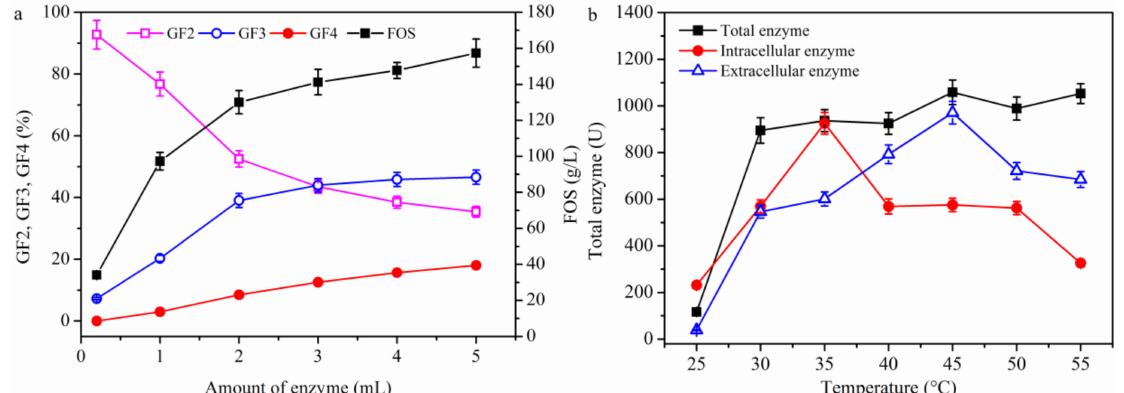
Figure 8. Effect of ( a ) adding enzyme and ( b ) temperature on FOS production. Enzyme indicates the fermentation broth that was used as the crude enzyme. The conditions were the same as in the enzyme activity measurement experiment but the amount of broth added was varied in ( a ), while the temperature was varied in ( b ). Data are given as the mean ± SD, n =